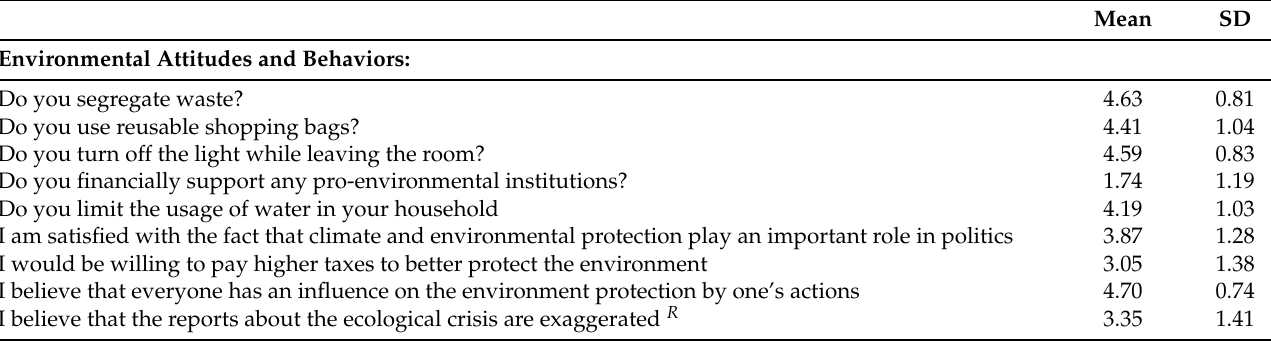
Table 2. Environmental attitudes and behaviors.